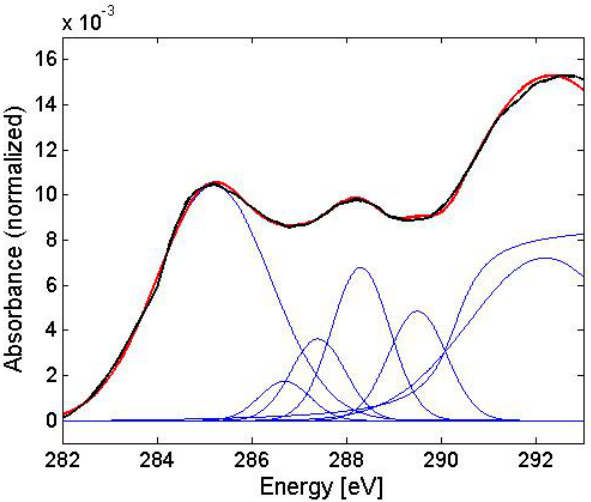
Fig. 6. Example of a gauss fitting of a NEXAFS spec- trum for wood combustion particles, the black solid line represents the original spectrum, the red one represents the fit. The maxima of the Gaussian peaks were placed at 284.2eV (quinone-C), 285.2eV (aromatic-C), 286.7eV (phenol- C), 287.4eV (aliphatic-C), 288.3eV (carboxyl-C), 289.5eV (O-